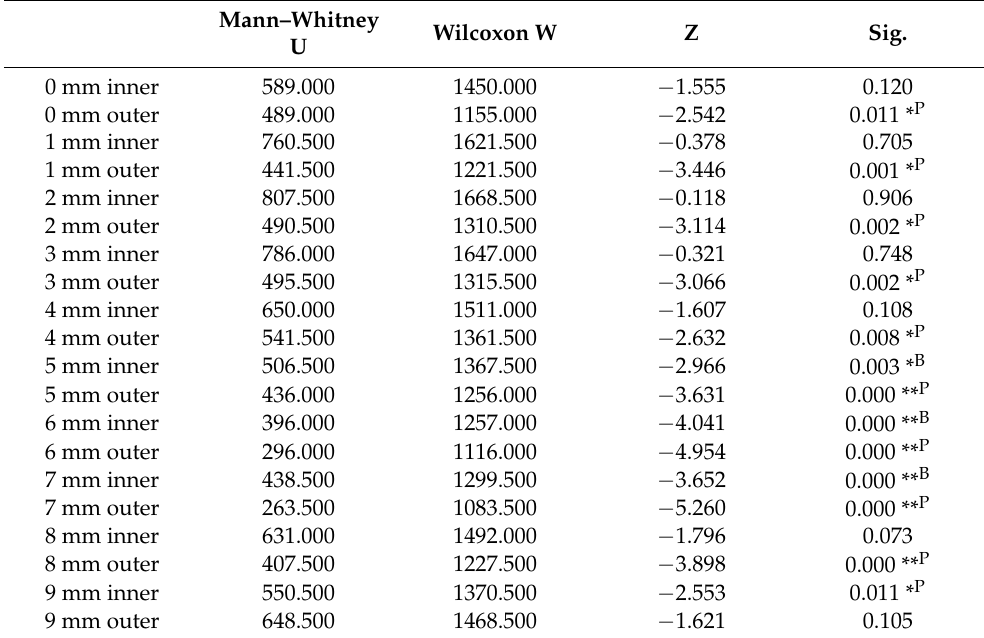
Table 2. Amounts of resin removed per